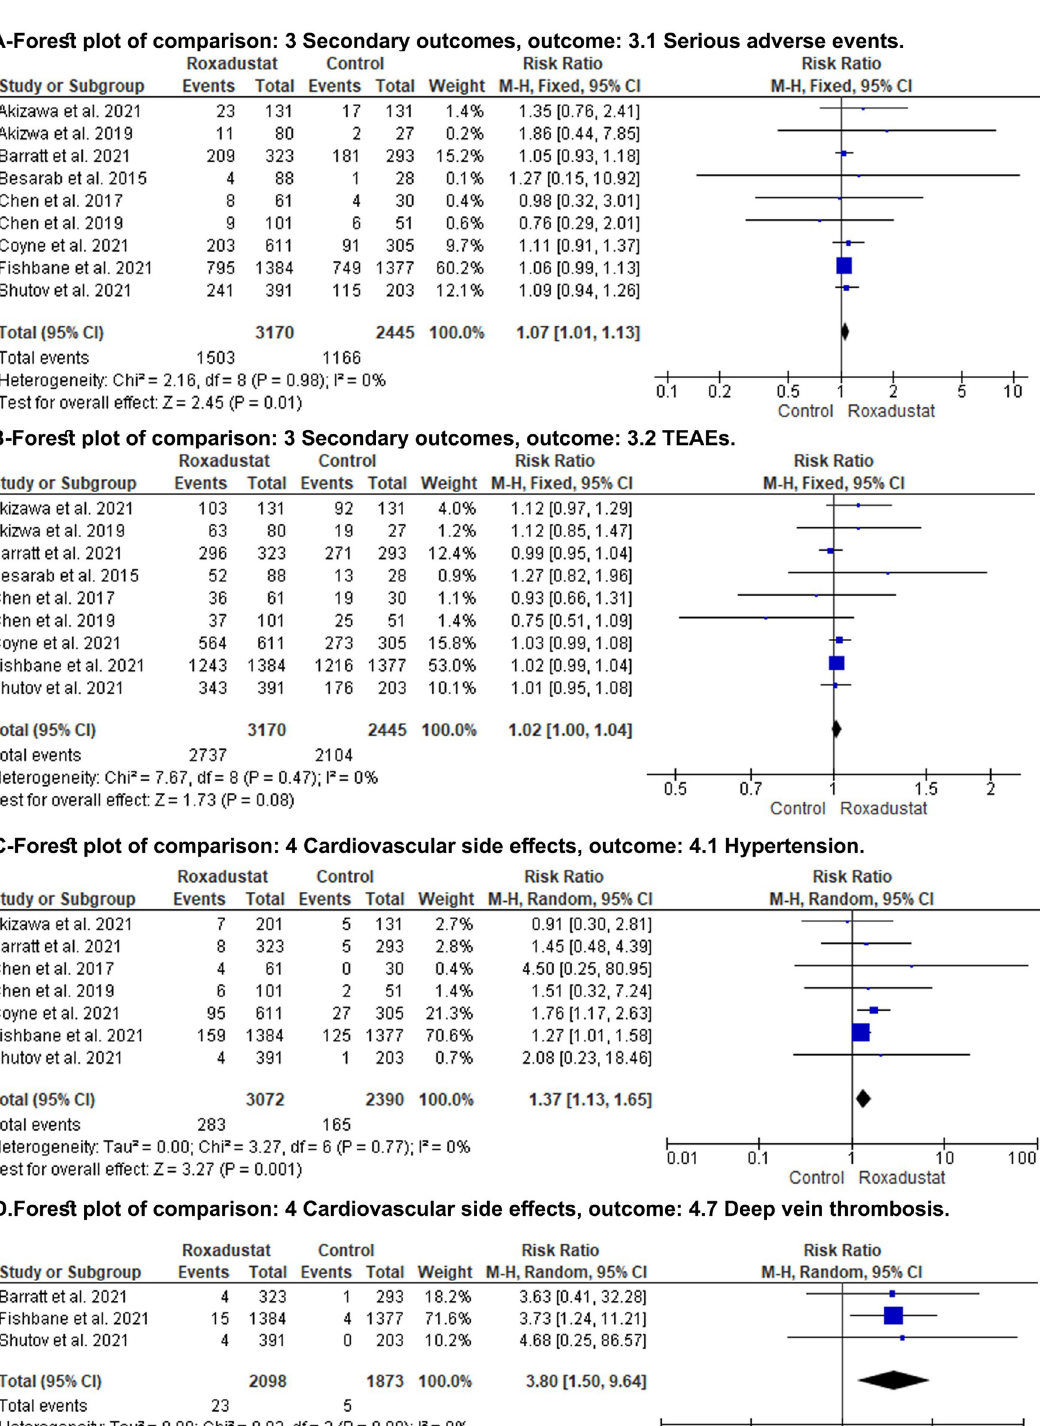
PLOS ONE | https://doi.org/10.1371/journal.pone.0266243 April 1, 2022 10 /